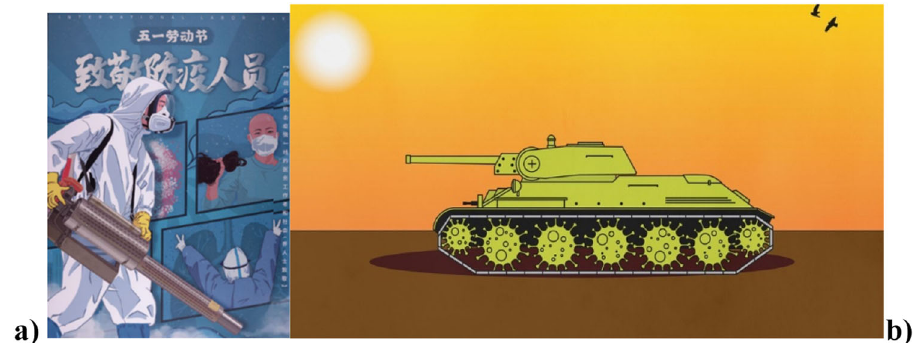
Fig. 8 Visual metaphors depicting the conceptualization of Covid as war. a Picture published in the online collection “ Chinese COVID-19 political propaganda poster collection ” of the Princeton University Library, available at the following address: https://catalog.princeton.edu/catalog/ 99120475213506421; b Picture published in the website of the online journal The Atlantic at the following address: